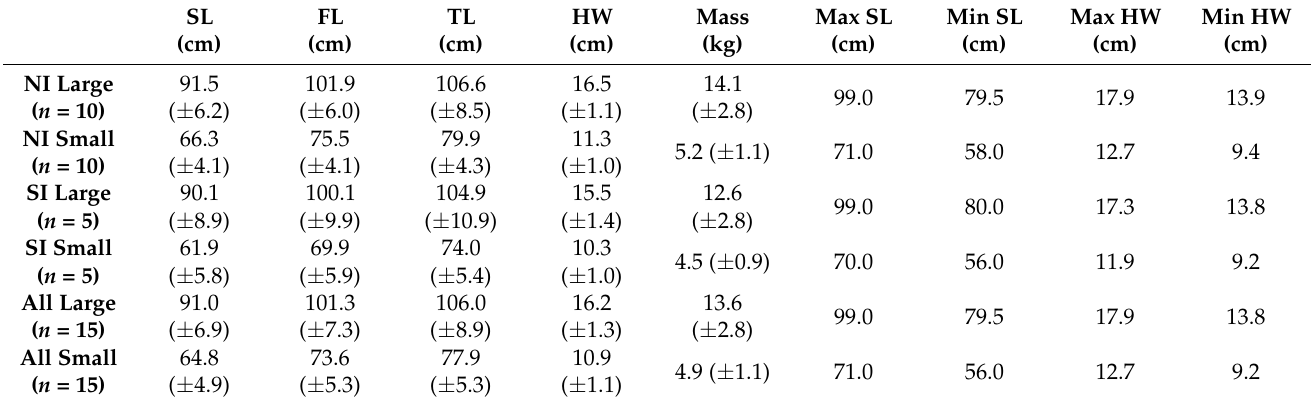
Table 1. Measurements of acoustically tagged red drum captured in the ITL impoundments (mean ± sd). Fish were divided into two size classes: Large (>13 cm head width (HW)) and Small (<13 cm HW). Ten Large and ten Small fish were captured in the north impoundment (NI). Five Large and five Small fish were captured in the south impoundment